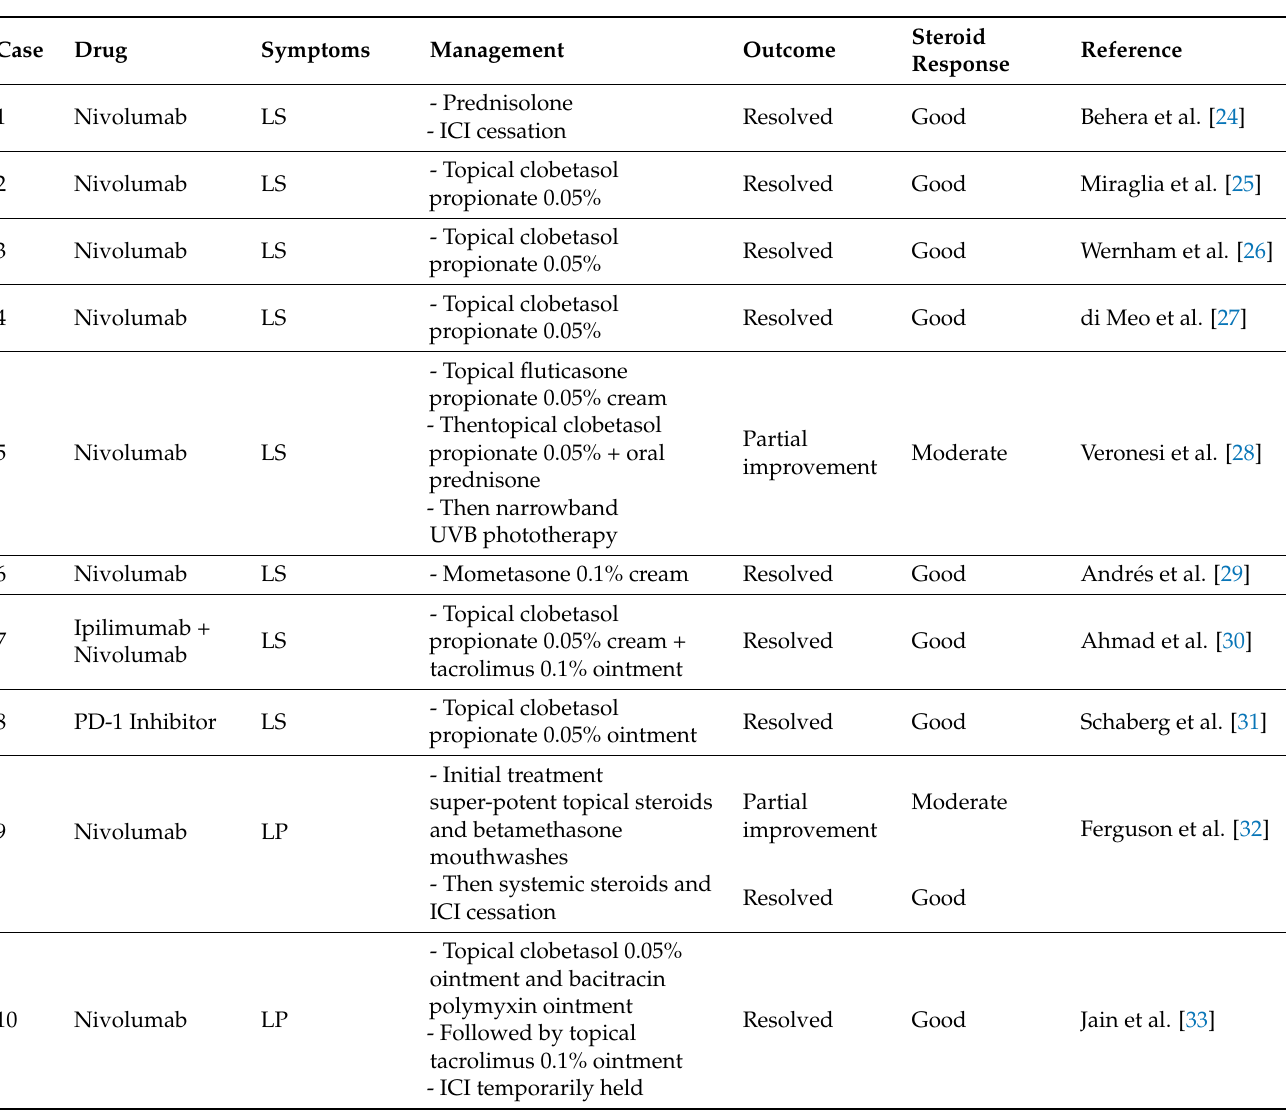
Table 3. Treatment outcomes of patients with lichen sclerosus and lichen planus associated with the use of immune checkpoint